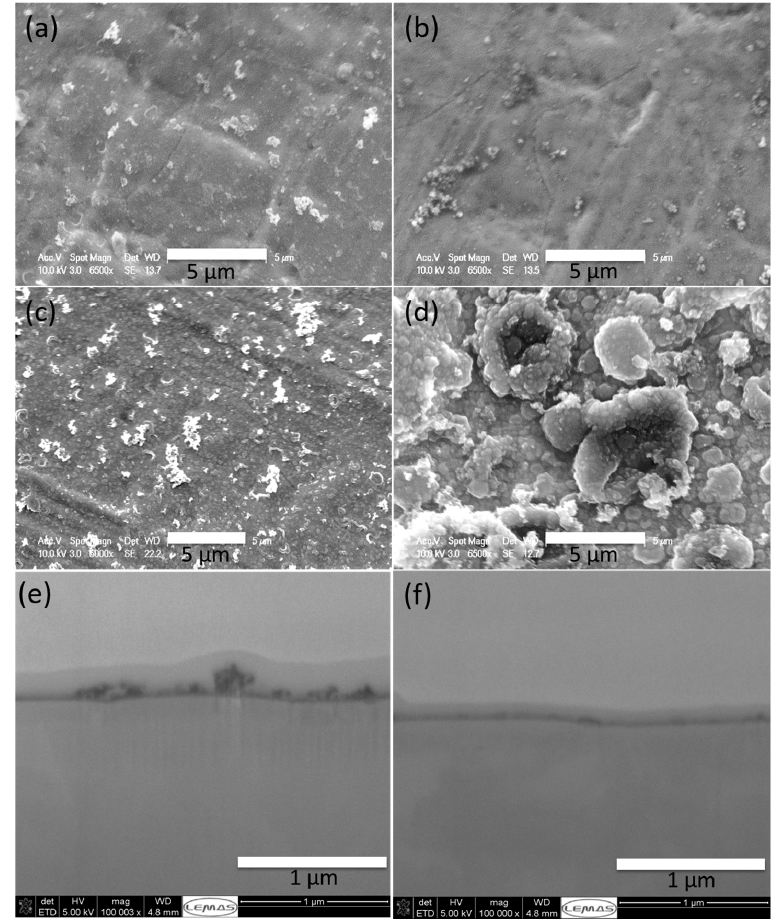
Figure 2. SEM images for PANI-TiN (0.5) with varied thickness; ( a ) five cycles, ( b ) 10 cycles, ( c ) 20 cycles, and ( d ) 50 cycles and FIB-SEM images for ( e ) 10 cycles PANI-TiN 0.1 and ( f ) 10 cycles PANI-TiN 0.5